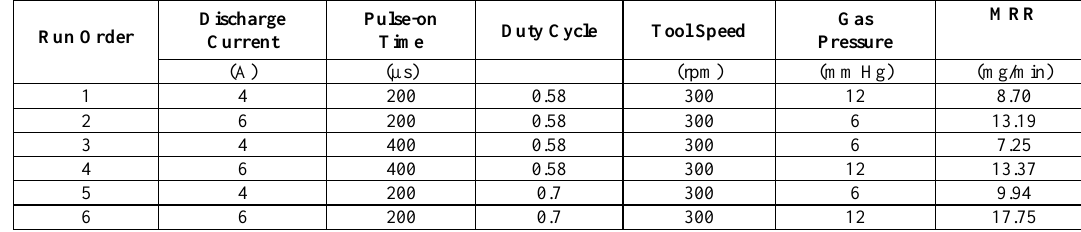
Table 3. Measured responses corresponding to each trial of GAEDD